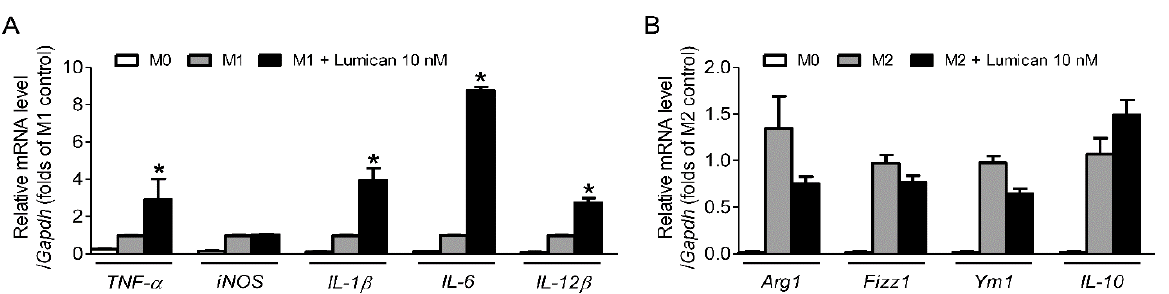
Figure 5. The effects of lumican on M1 or M2 polarization. ( A,B ) Primary mouse BMMs were incubated with 30 ng/mL M-CSF for 24 h and then treated with medium containing 10 ng/mL LPS and 10 ng/mL IFN- γ (M1 polarization) or 10 ng/mL IL-4 (M2 polarization) for an additional 24 h. Cells were assayed by quantitative RT-PCR analysis using ( A ) TNF- α , iNOS , IL-1 β , IL-6 , or IL-12 β (M1 marker genes)-specific primers and ( B ) Arg1 , Fizz1 , Ym1 , or IL-10 (M2 marker genes)- specific primers ( n = 3). PCR primer sequences were retrieved from the online PrimerBank database. Data are means ± SEM. * p < 0.05 vs. M1 control.